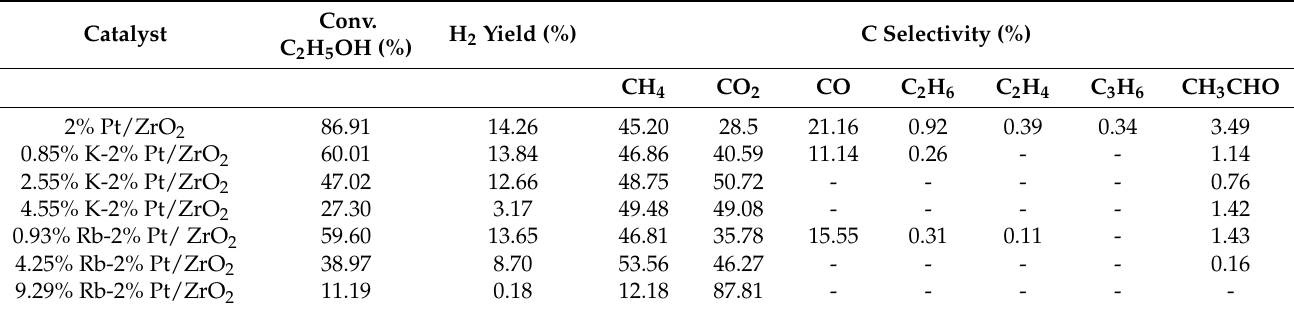
Table 3. ESR catalytic activity for K-series and Rb-series (300 ◦ C, 1 atm, 190,560 Ncc/h/g cat , feed: C 2 H 5 OH 2.98% H 2 O 26.14% N 2 70.88%).